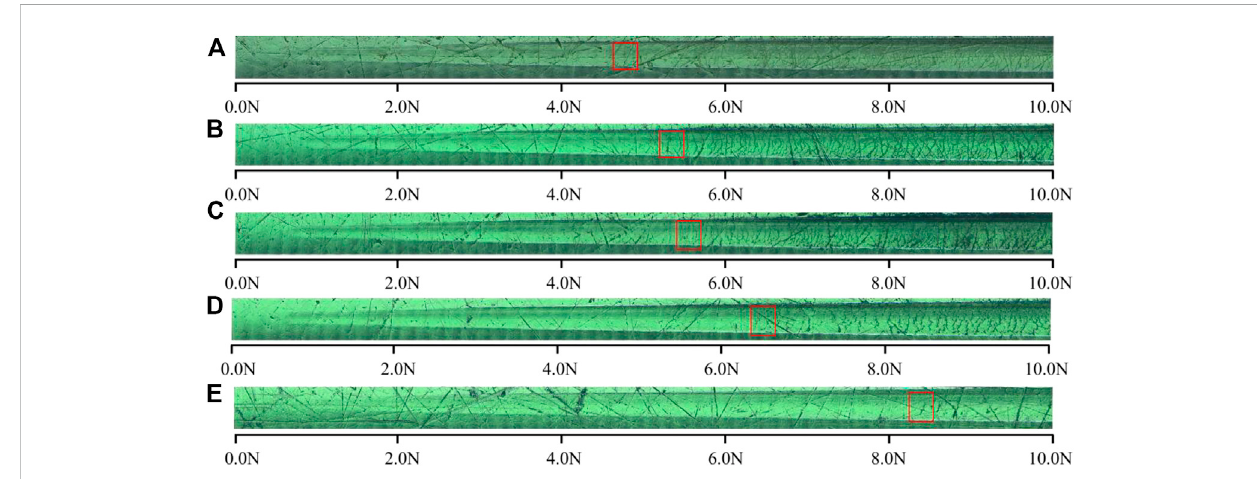
FIGURE 5 The optical images of scratch tracks of PI surface treated by carbon plasma with different graphite target currents: (A) 1.0 A (B) 1.5 A (C) 2.0 A (D) 2.5 A (E) 3.0 A.